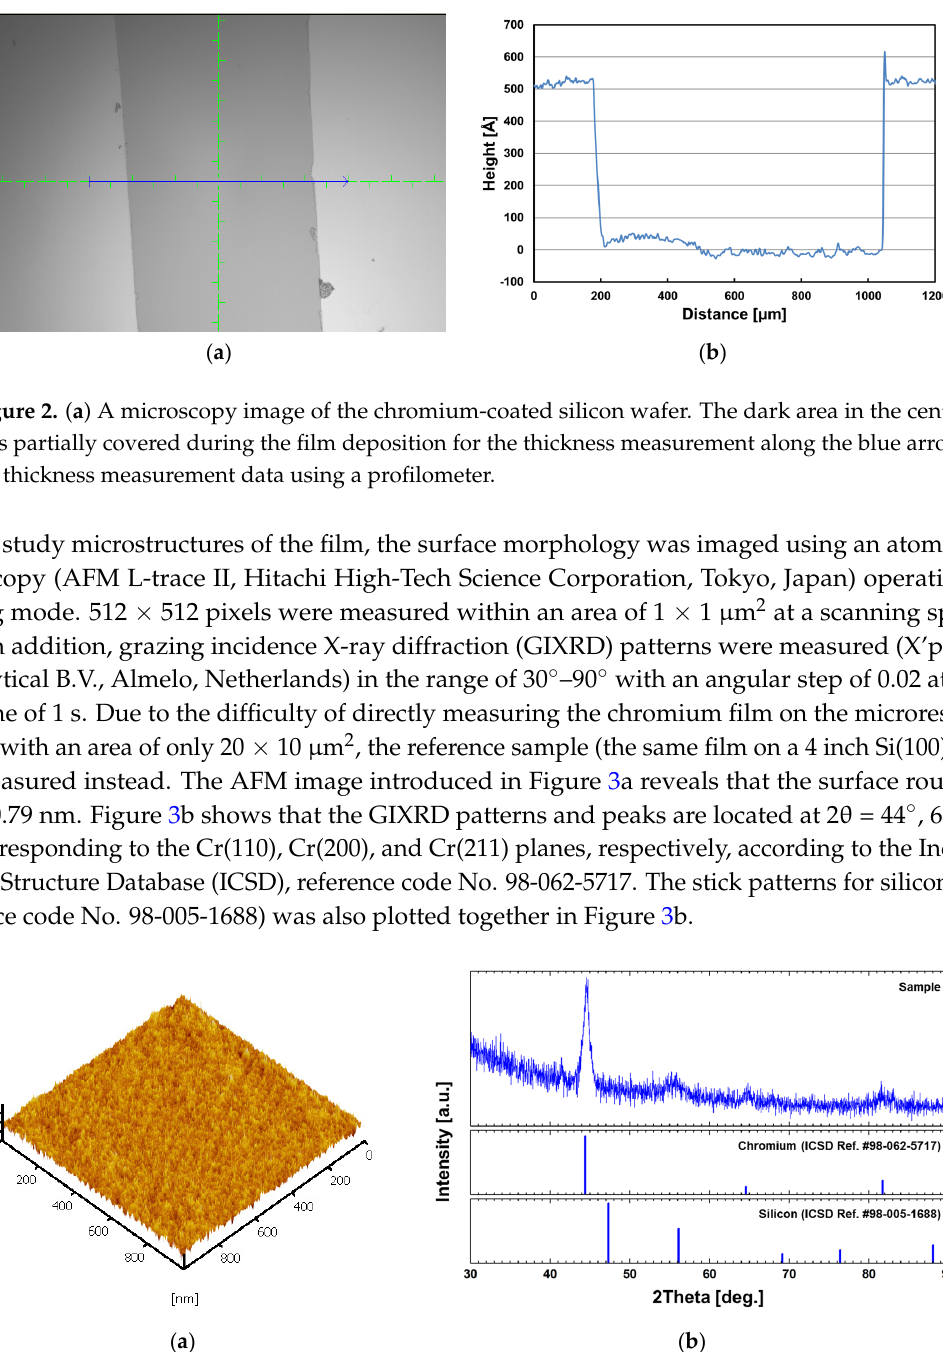
Figure 3. Sample characteristics. ( a ) An atomic force microscopy image of the chromium film on the micromechanical resonator. The surface roughness ( R a ) is 0.79 nm; ( b ) grazing incidence X-ray diffraction (GIXRD) peaks on the chromium film on a Si(100) substrate.